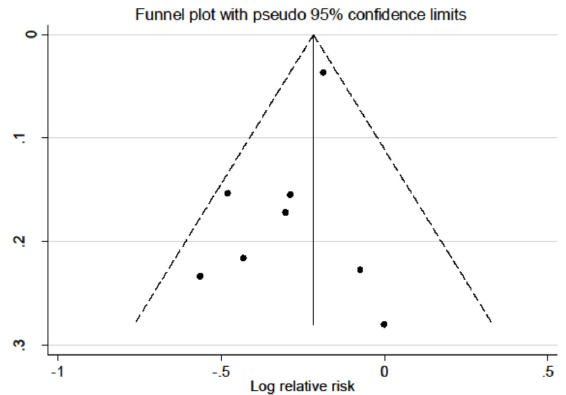
Figure 4. Funnel plot for all studies included in the meta ‐ analysis.